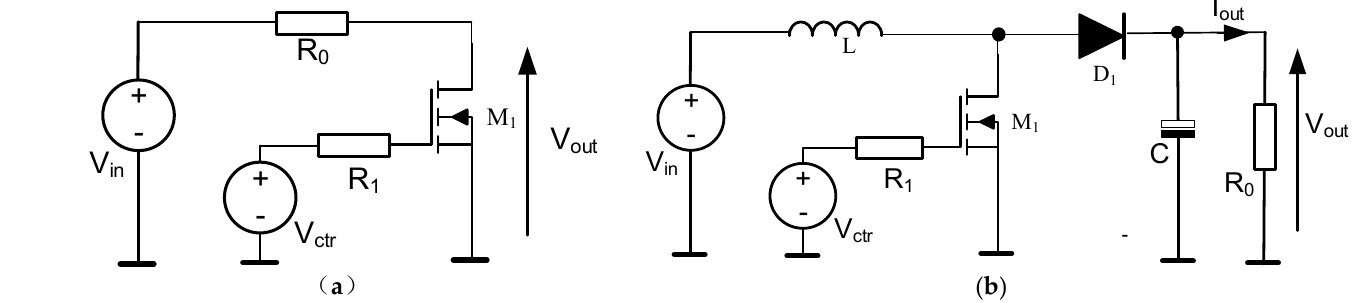
Figure 3. Diagrams of the investigated circuits: ( a ) transistor switch, ( b ) boost converter. In both the considered circuits, a SiC-MOSFET transistor of the SCT3060AL type is used. This transistor is characterized by the maximum allowable value of the voltage between the drain and the source equal to 650 V, the maximum allowable drain current value of 39 A and the resistance of the switched on channel R ON = 60 m Ω [31]. In the practical application, such a transistor can be driven using monolithic drivers, e.g., offered by Infineon Technologies. One of the possible solutions is the driver IR2125 [33].